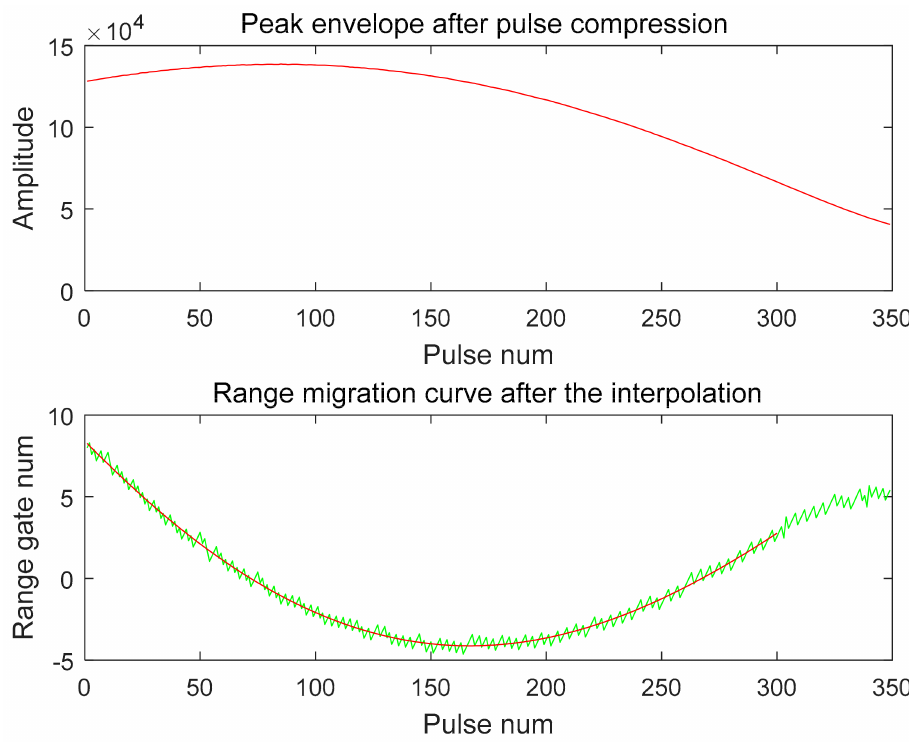
Figure 9. Extracted range migration curve and peak envelope after pulse compression.